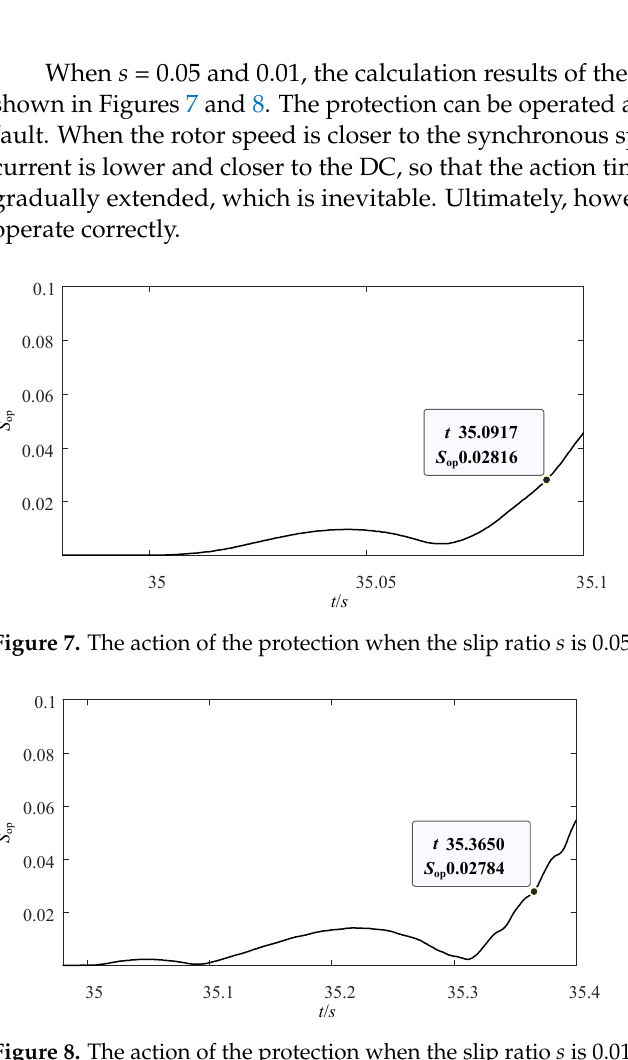
Figure 9. Position of the possible end short-circuit faults. The above VSPSGM is still taken as an example. Through the statistical analysis, the number of rotor winding short-circuit faults that may occur in the unit is as shown in Table 2, and the total number of faults is 12,054. Table 2. The number of possible internal short-circuit faults in rotor windings. Faults in the Same branch With Different Short Turns